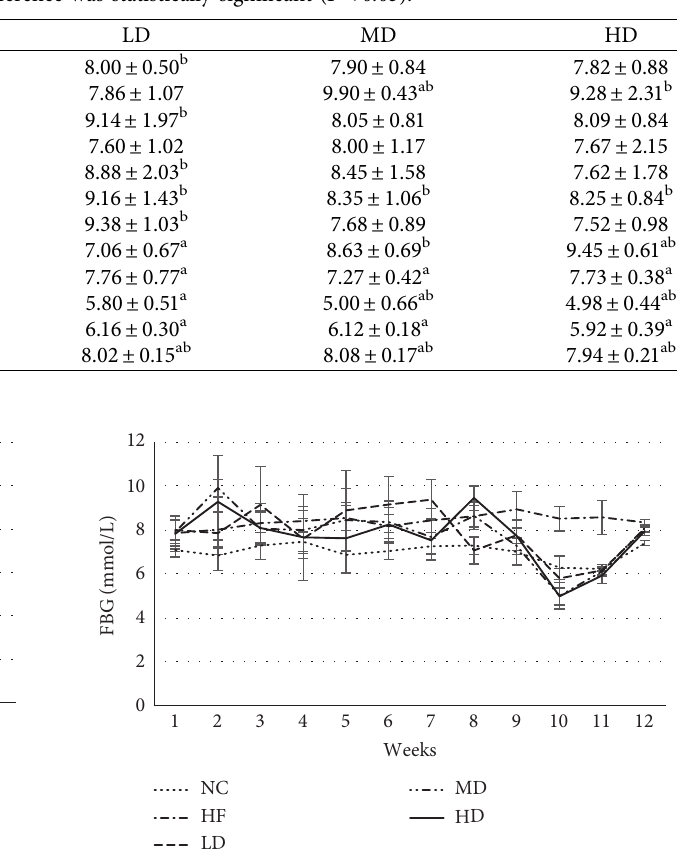
Figure 3: Mean value of FINS, FBG, and HOMA-IR at the 12 th week of mice in each group (means ± SD). ∗ Compared with the HF group, the difference was statistically significant ( P < 0 . 05).